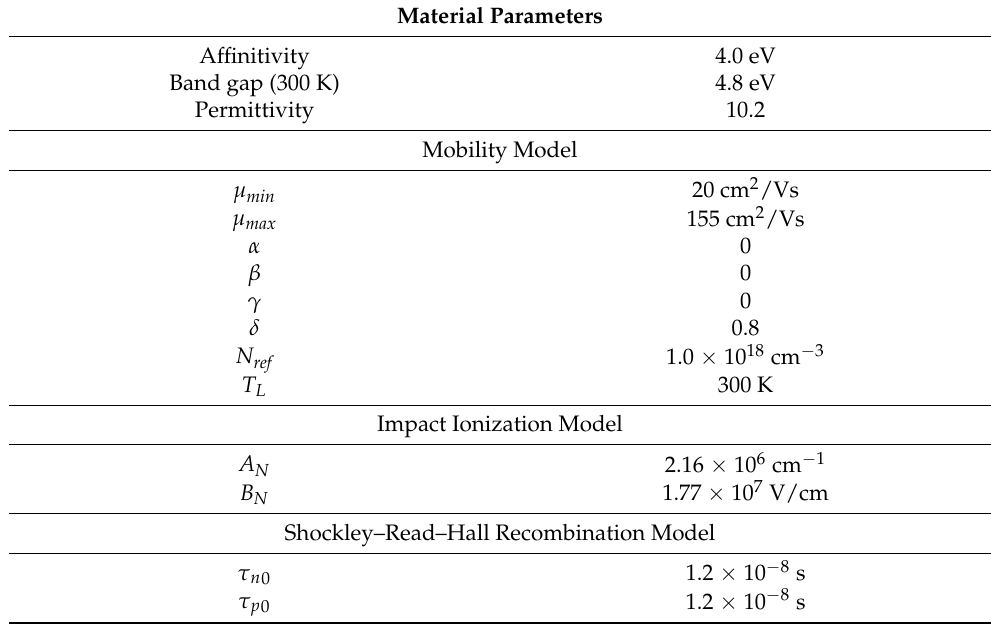
Table 1. Material and physical model parameters used for TCAD simulations